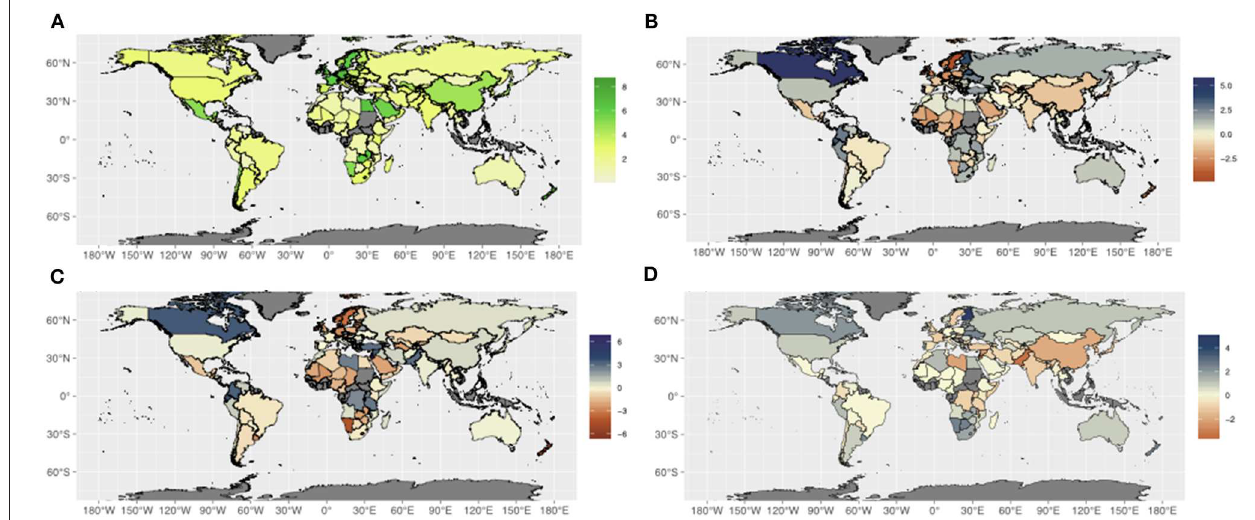
FIGURE 4 | Country-level yield of wheat in 2007 (t/ha): (A) FAOSTAT data, (B) error of the predicted yields, (C) error explained by crop model error, and (D) error explained by the seasonal prediction